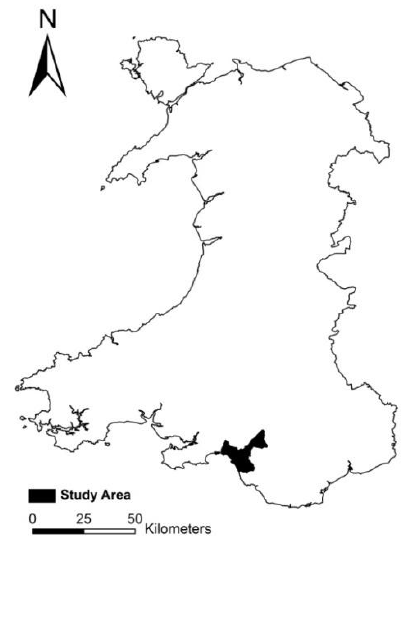
Figure 2. Sites investigated using Definiens Developer: Neath-Port Talbot County Borough Council (CBC), South Wales